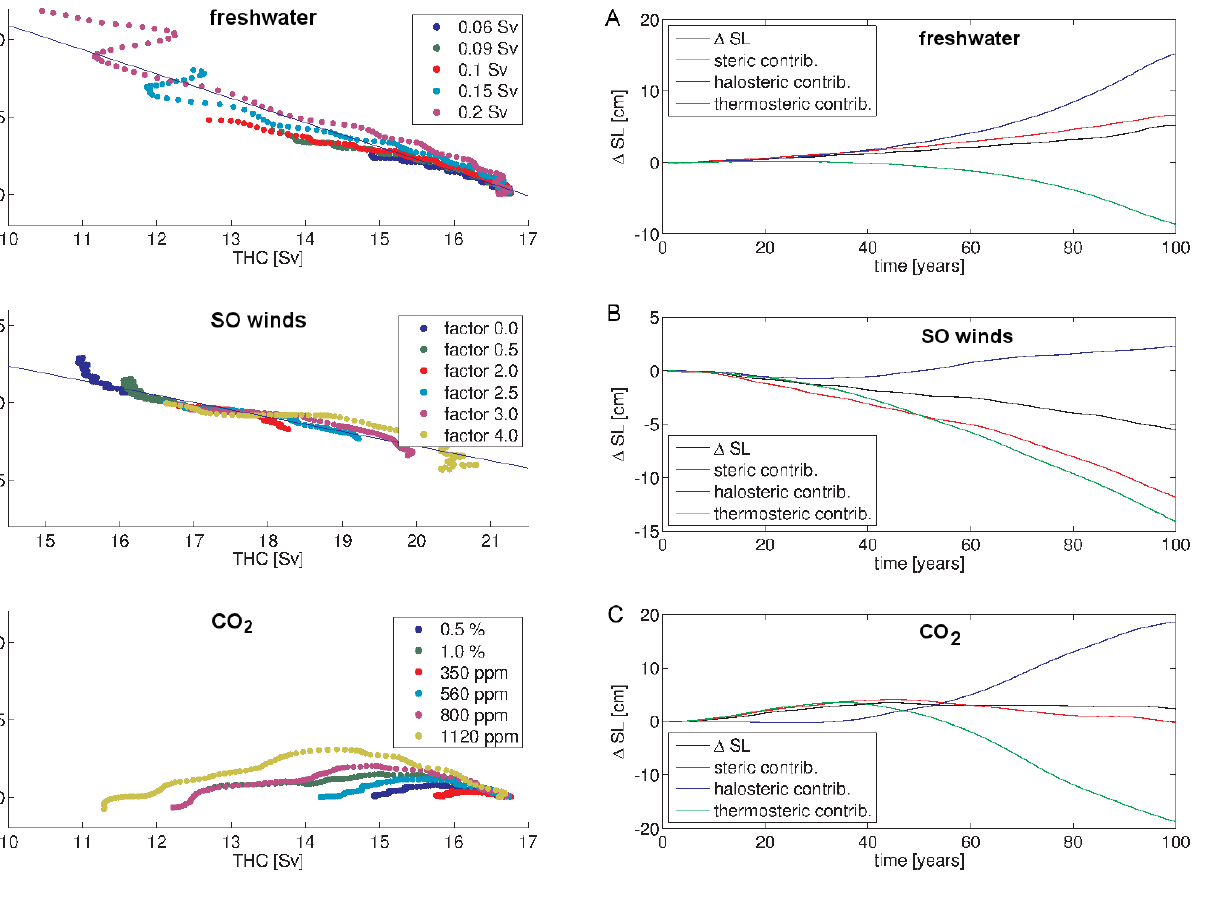
Fig. 5. 1 SL between North and Central and the contributions due to Fig. 4. 1 SL between North and South for the following forcings: Fig. 4. ∆ Fig. 5. ∆ SL between North and Central and the contributions due to steric SLR as well as a subdivision SL between North and South for the following forcings: (A) freshwater (slope: (cid:0) 1.57 cm Sv (cid:0) 1 ), steric SLR as well as a subdivision into halosteric and thermosteric (A) freshwater (slope: − 1.57cmSv − 1 ), (B) Southern Ocean winds into halosteric and thermosteric SLR: (A) freshwater forcing (0.1 Sv), (B) Southern Ocean winds (factor 3.0), SLR: (A) freshwater forcing (0.1Sv), (B) Southern Ocean winds (slope: − 0.94cmSv − 1 ), (C) CO 2 . (factor 3.0), (C) linear increase of CO 2 to (C) linear increase of CO 2 to 1120 ppm.